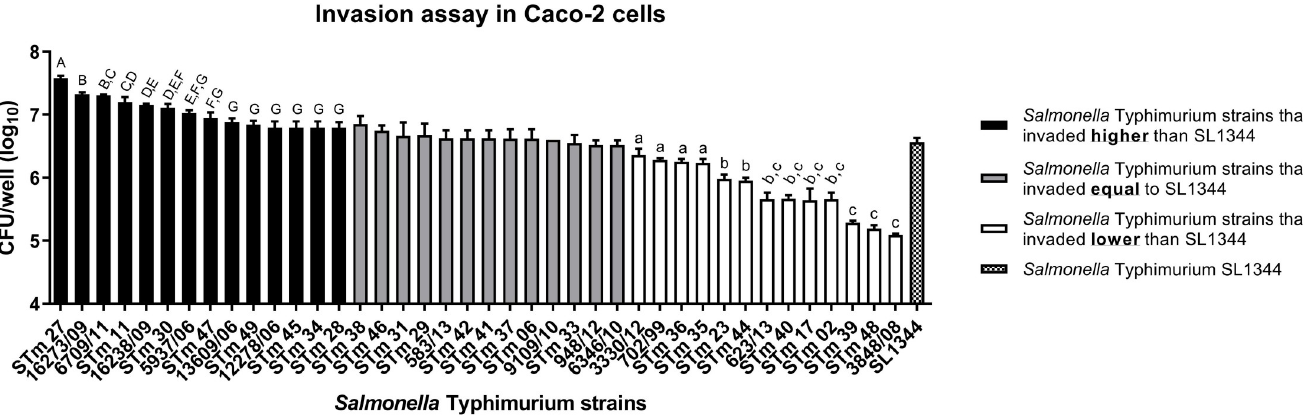
Fig 1. Invasion assay in Caco-2 epithelial cells for the 40 S . Typhimurium strains isolated from humans and foods and for the S . Typhimurium SL1344 reference. The means followed by different letters differ statistically from each other at a level of 5% significance. The error bars represent standard deviation of biological